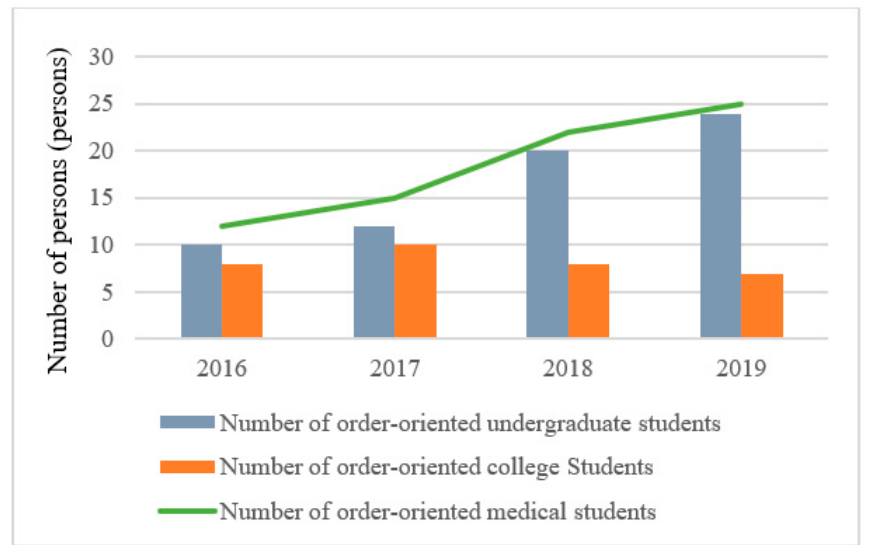
Figure 6. Number of order-oriented medical students recruited in Yushu Prefecture from 2016 to